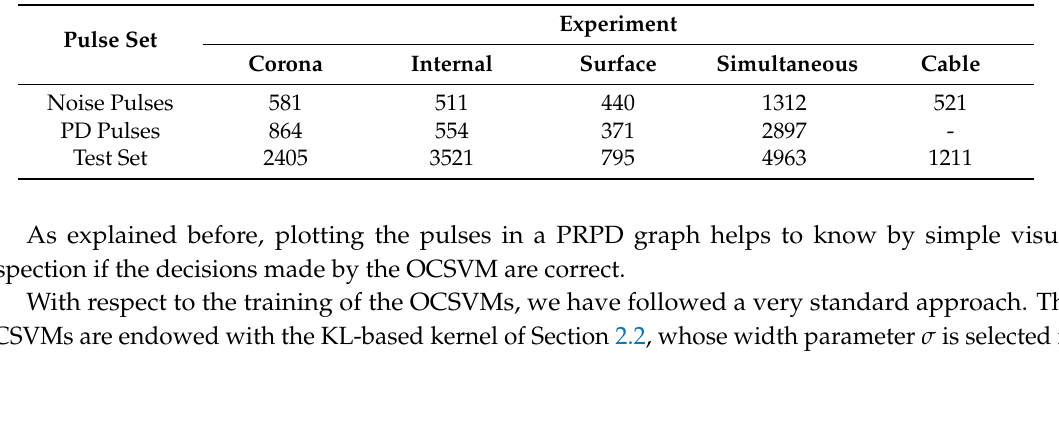
Table 1. Sizes of the pulses sets used in the experimental